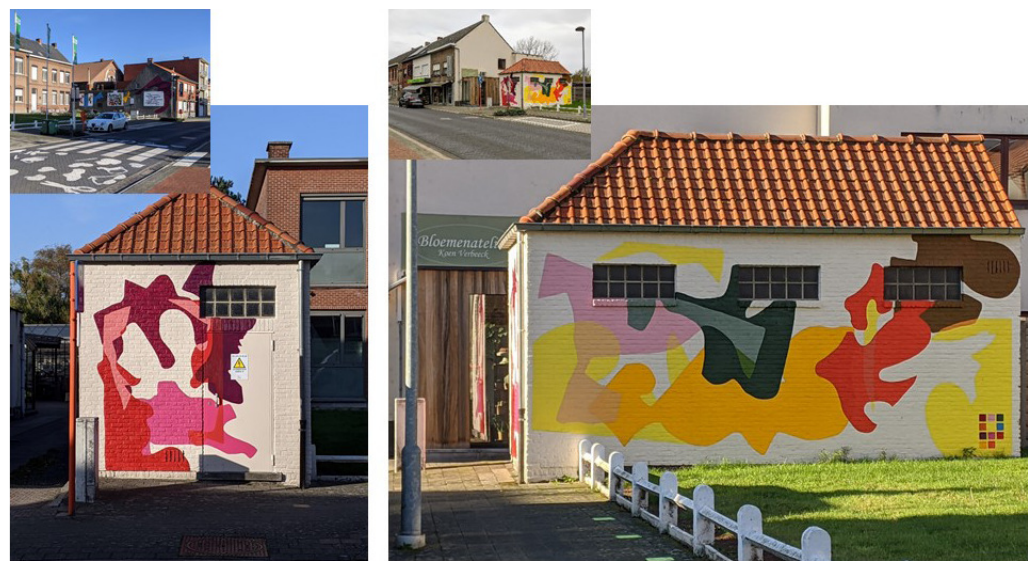
Figure 5. The electricity supply house is the accomplishment of 35 participants working together. Each shape is cut by someone, each colour is printed by someone else, and the actual painting on the wall is done by 12 other participants. Source: Ruth